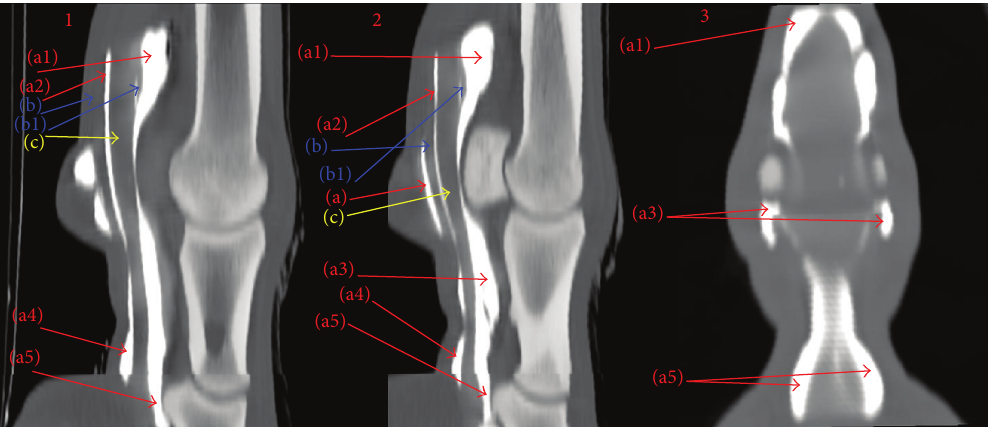
Figure 3: Multiplanar reconstruction (MPR). Computed tomographic tenography of ex vivo normal forelimbs of horses: representative images of sagittal (1), parasagittal (2), and dorsal (3) scans of DFTS. (a1) Dorsal proximal recess, (a2) palmar proximal recess, (a3) collateral recess, (a4) palmar distal recess, and (a5) dorsal distal recess. (b) SDFT and (b1) manica